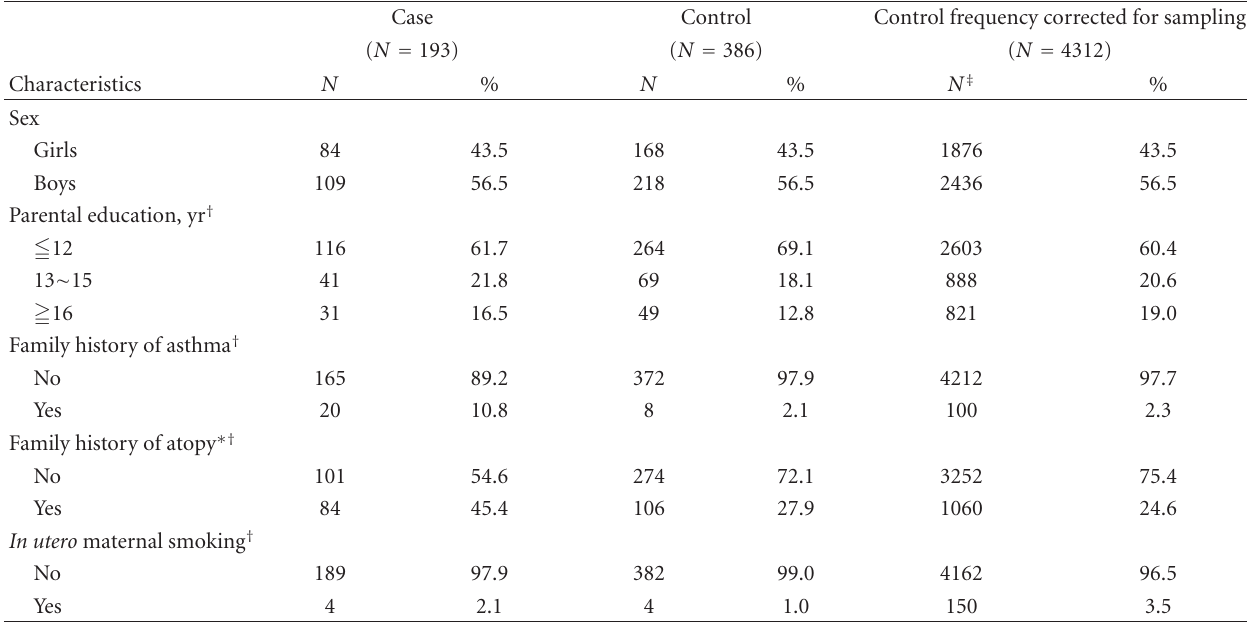
Table 1: Demographic characteristics of the study